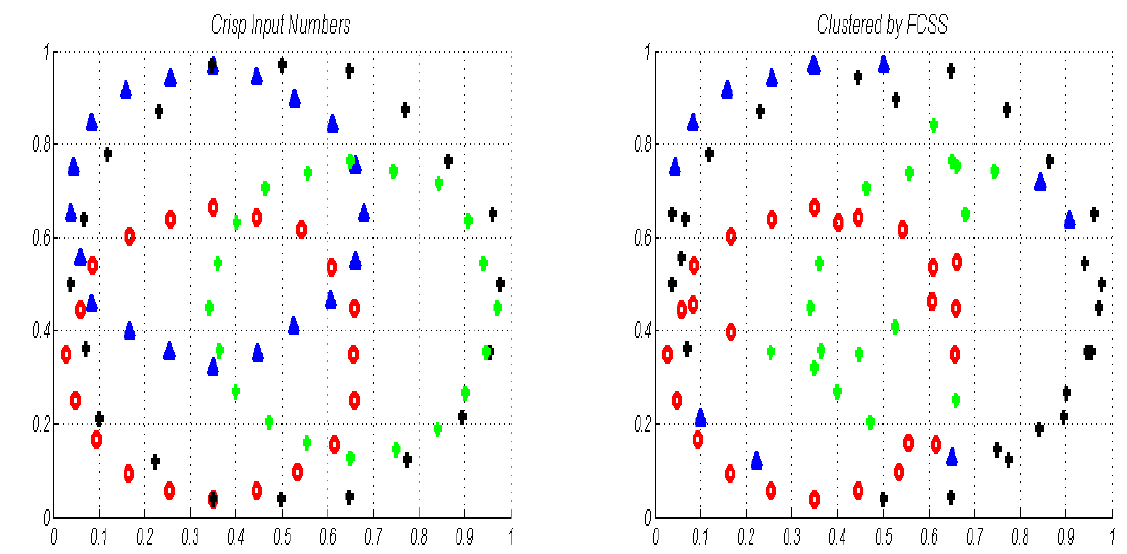
Figure 7. Conventional FCSS clustering over crisp input numbers include four complexity interference classes red, blue, black and green with (20,20,20,20) members (second step of state 3). Table 9. CM of VFCSS applied over LR-type fuzzy numbers of Figures 2 and 3 (first and second steps of state 1).